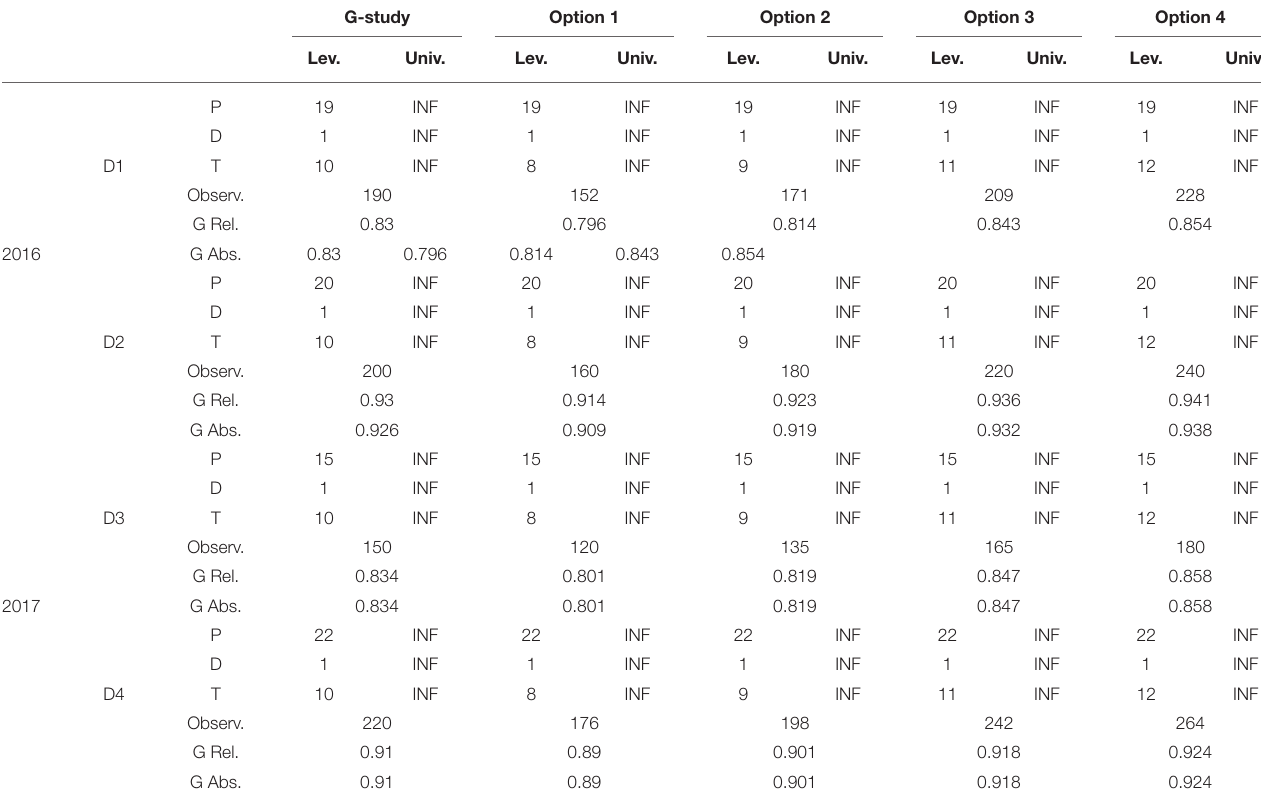
TABLE 2 | Optimization of decision study by task